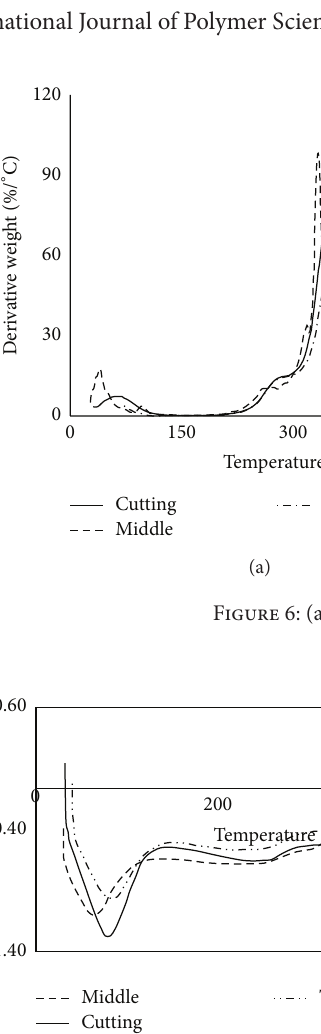
top and middle portions. On the other hand, the crystallinity of different portions of jute fiber was similar. However, there was a small difference in the position of the peaks. The middle portion of jute fiber also had higher thermal stability as compared to the other two portions. Thus the middle portion should be used as reinforcement in